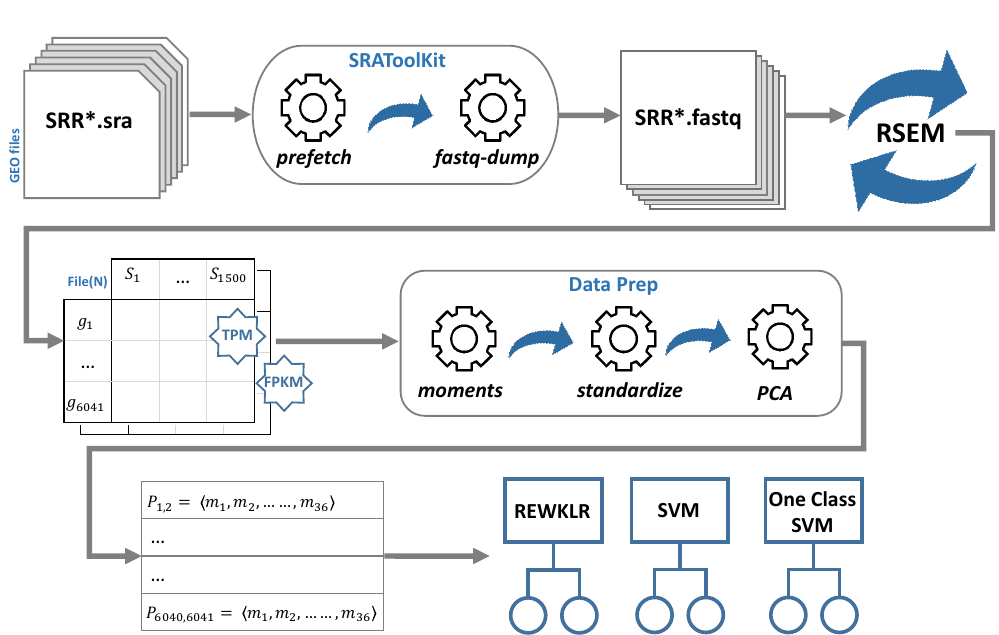
Figure 1. The general pipeline adopted in this work is represented in three major sections. Section 2.1: RNA-seq data analysis is summarized in the top part of the figure. Sequence Read Archive files are converted to fastQ files using SRAToolKit, then fed to the RSEM tool for gene quantification. The middle part illustrates the data preparation for system classifications, Section 2.2. The files containing the values of count reads for the matrix (genes x samples) are prepared for analysis by calculating the moments for each pair of genes, standardizing each moment, and then applying the Principal Component Analysis (PCA). The bottom part shows Section 2.3: training data and models. All pairs of genes are represented by 36 moments and fed to the kernel classification models for training and